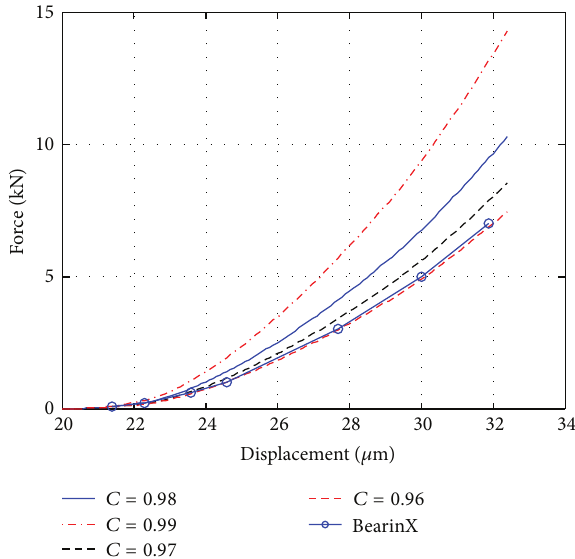
Figure 9: Effect of osculation number on radial force-displacement relationship.